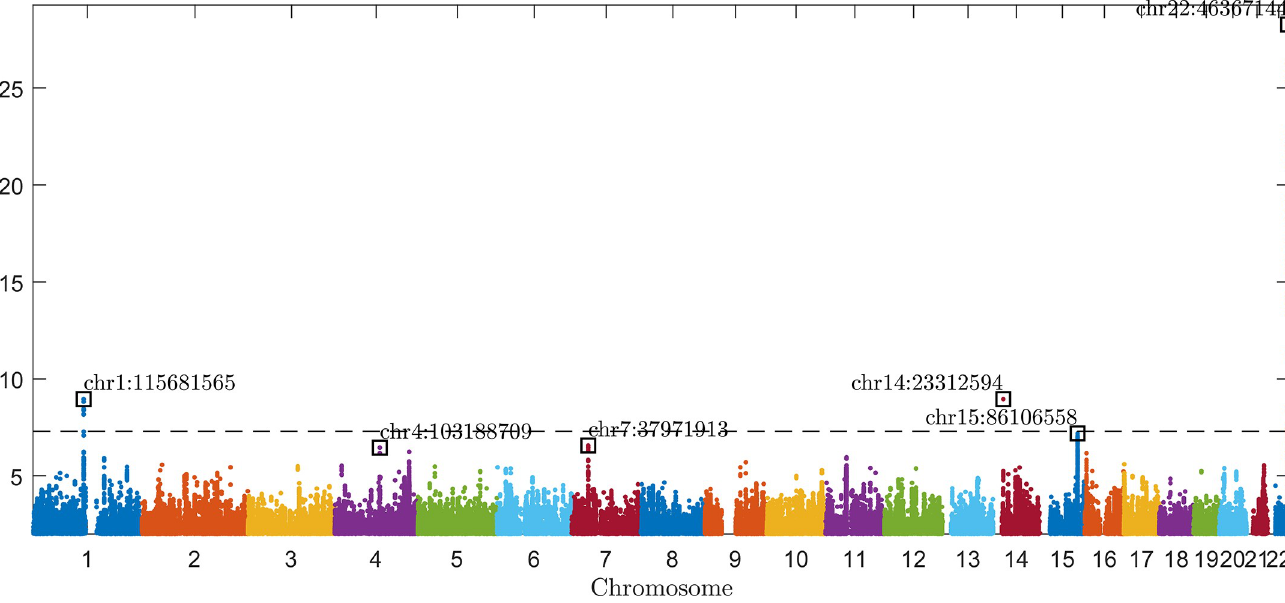
Fig 1. Manhattan plot of discovery GWAS for frozen shoulder in UK Biobank. The plot shows–log10(p) values for each single nucleotide polymorphism [SNP] in the HRC Imputation Panel and their association with frozen shoulder defined by ICD10, OPCS codes and GP records with p < 0.01, computed using BOLT-LMM and plotted using an in-house MATLAB script which we have made publicly available on the MATLAB File Exchange [31]. The horizontal dashed line is the genome-wide significance threshold at p = 5 × 10 − 8 . Positions are based on the hg19 reference human genome.